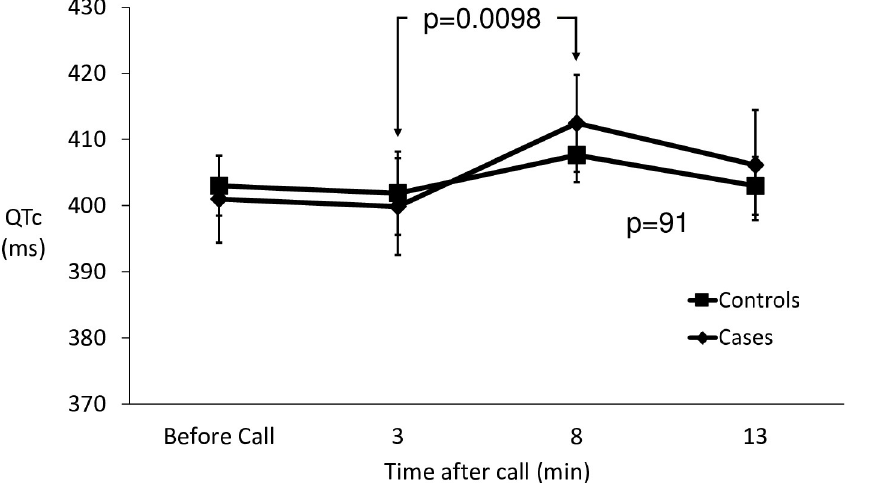
Fig 6. The effects of an unheralded phone call on QTc in cases and